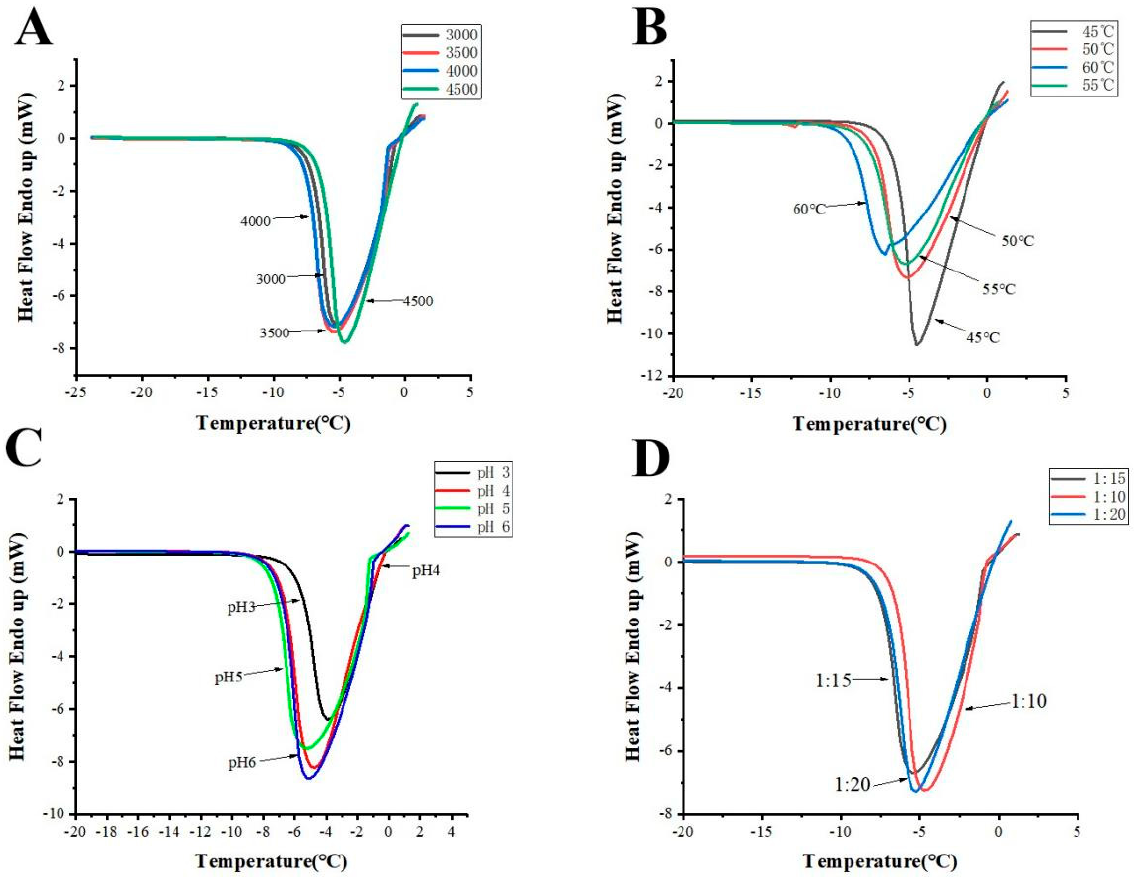
Figure 2. DSC curves ( A – D ) of Ctenopharyngodon idella scale hydrolysates after enzymolysis with different concentrations of papain ( A ), hydrolysis temperatures ( B ), pH ( C ), and substrate concentrations ( D ). Table 1. The hold and onset temperature (T h and T o ), recrystallization enthalpy, ice fractions and THA of BSA and Ctenopharyngodon idella scale hydrolysates after enzymolysis with different papain concentrations, hydrolysis temperatures, pH, and substrate concentrations.